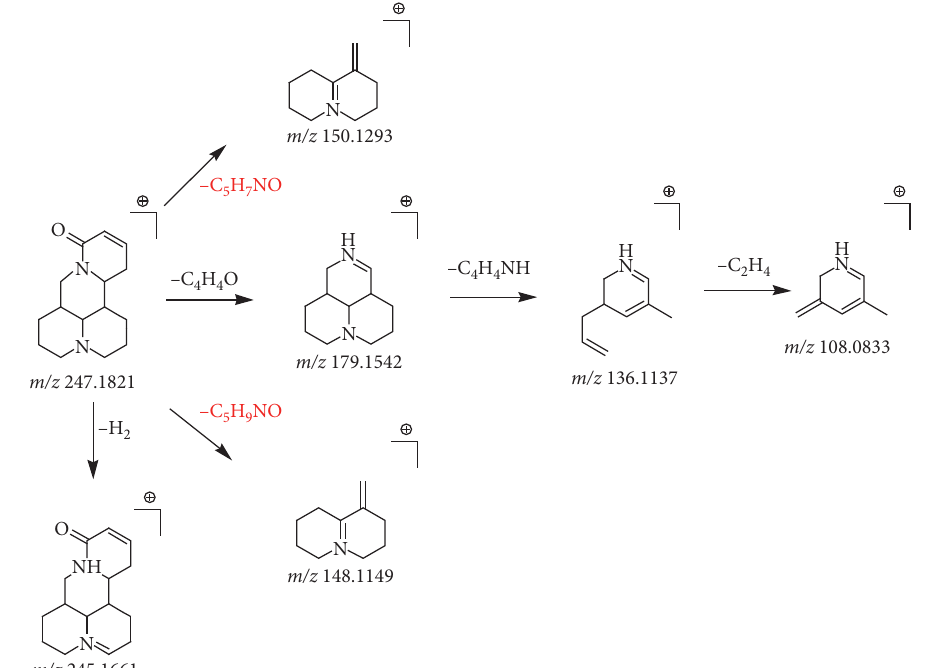
Figure 4: The fragmentation process of sophocarpine in the positive ion